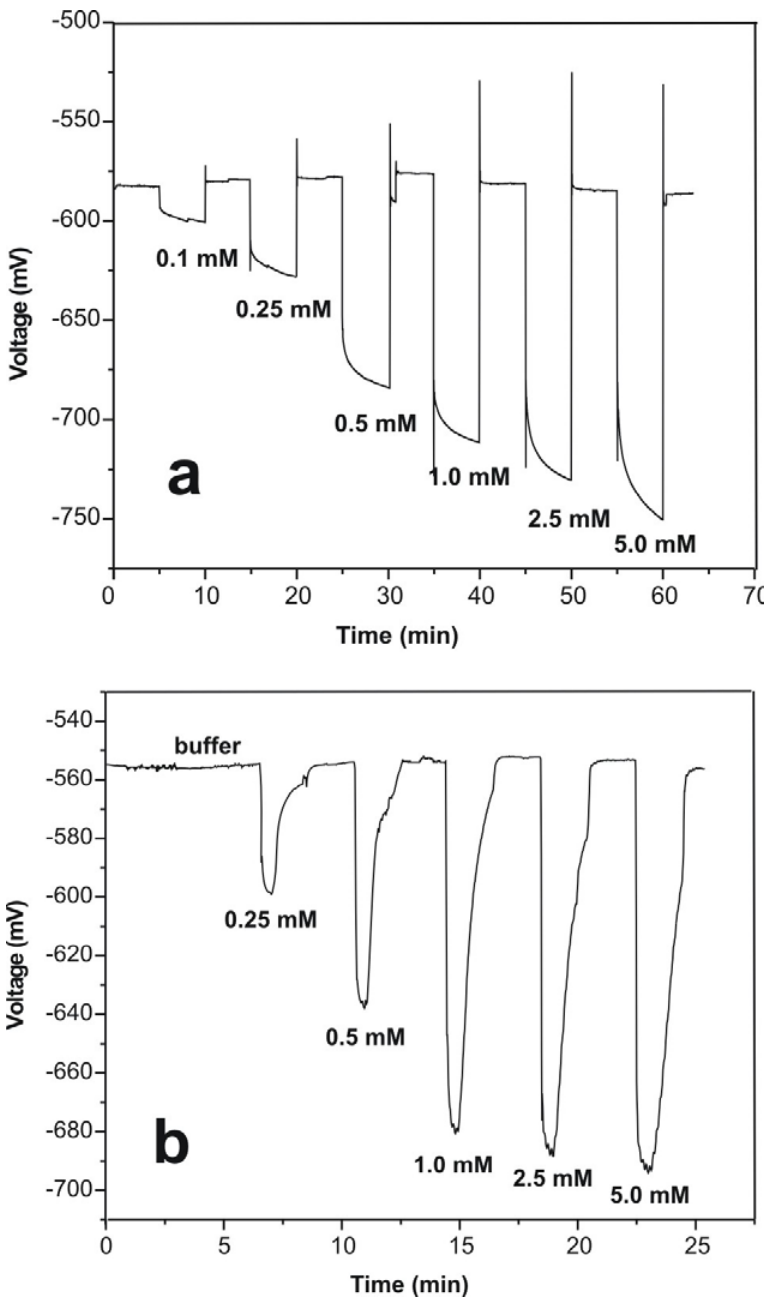
Figure 5. Typical ConCap response of the EIS penicillin sensor in static (a) and FIA (b) mode,